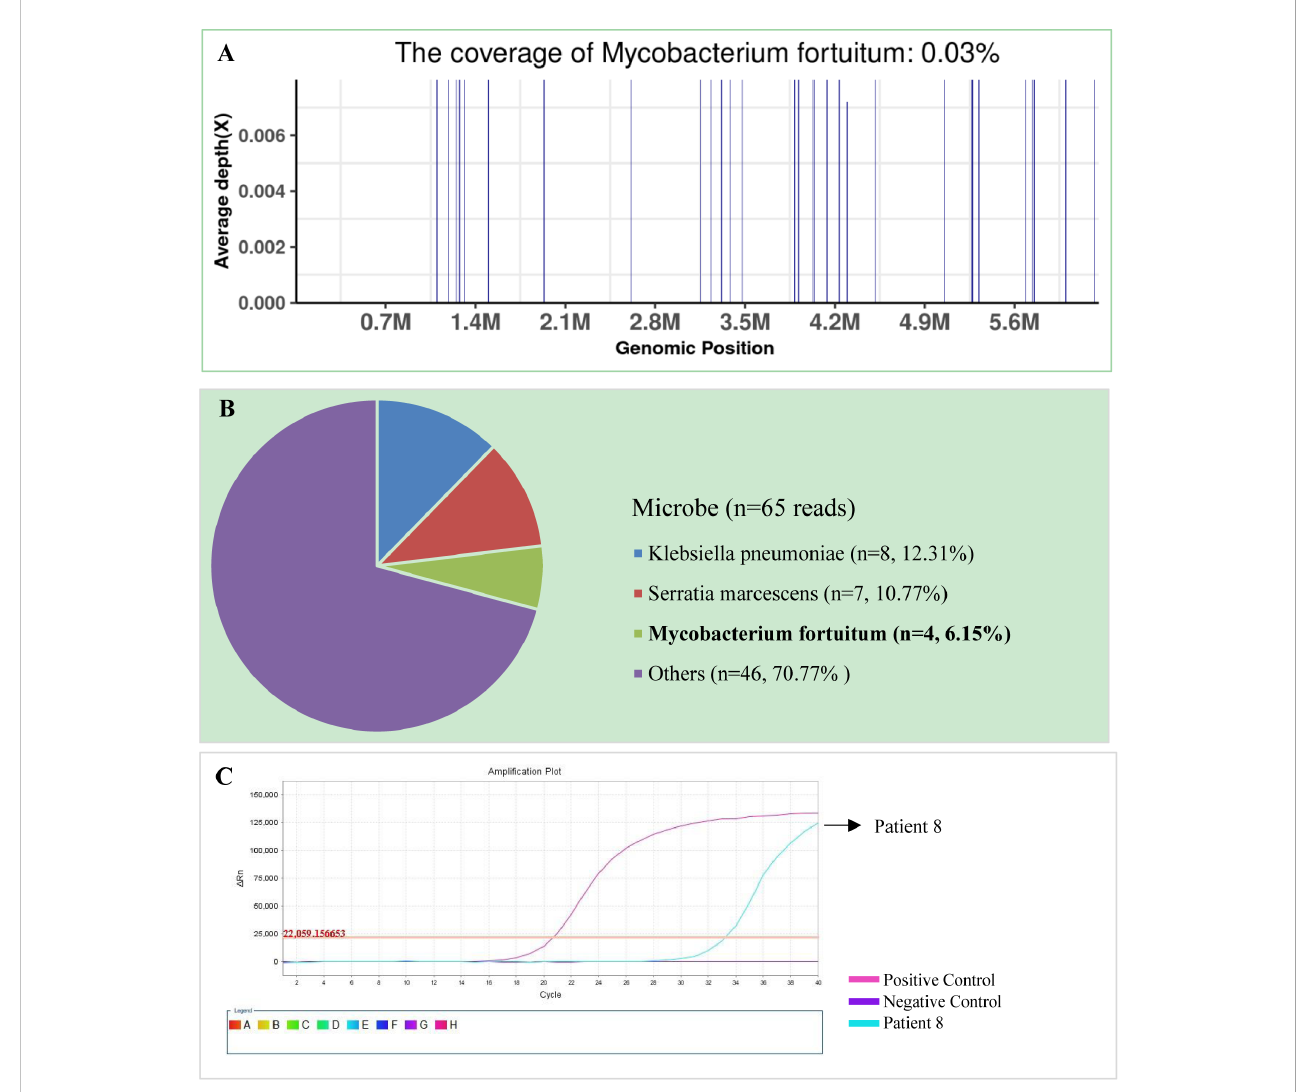
FIGURE 1 The bronchoalveolar lavage fl uid (BALF), metagenomic next-generation sequencing (mNGS), and quantitative polymerase chain reaction (PCR) results for patient 8. (A) The genome coverage of Mycobacterium fortuitum , with 30 reads mapped to the genome of M. fortuitum . (B) The species composition of the BALF microbes, with four species-speci fi c reads mapped to the genome of M. fortuitum . (C) Positive qPCR results for M. fortuitum